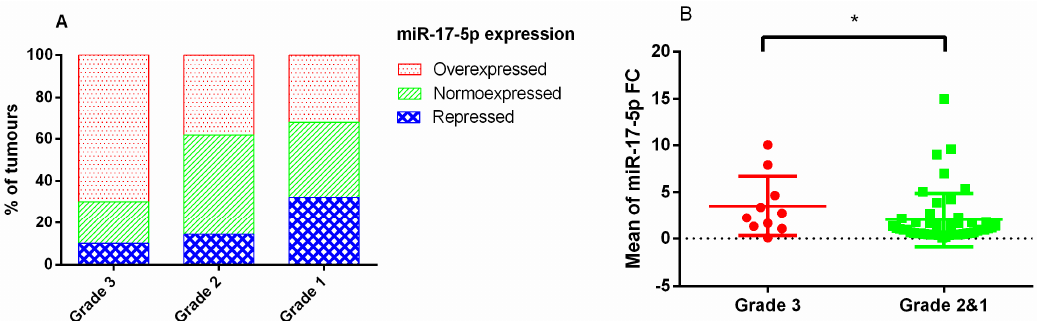
Figure 2. ( A ) Percentage of tumours with miR-17-5p overexpressed, normoexpressed, or repressed depending on grade of invasiveness and proliferation in the whole series; ( B ) Differences in miR-17-5p fold change expression between proliferative and invasive tumours (grade 3) and non-proliferative or non-invasive tumours (grades 2 and 1) in the whole series. * Mann–Whitney U, p = 0.041.